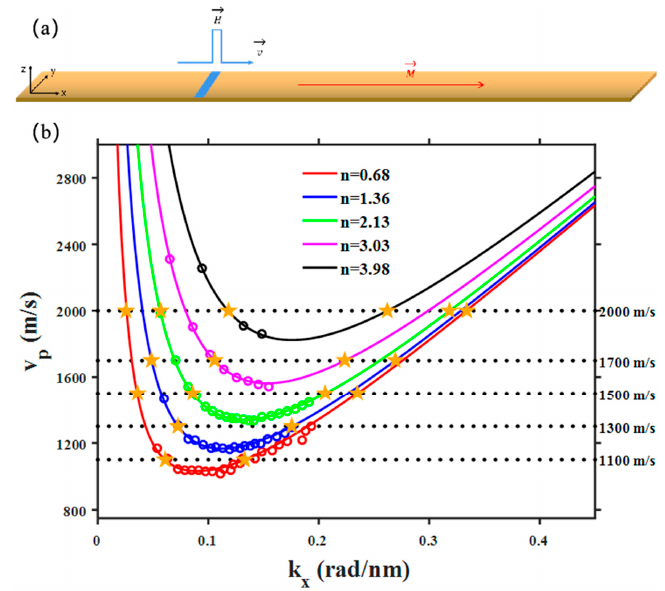
Figure 3. ( a ) A localized field pulse (blue) moving along the strip to generate Cherenkov-like excitation of SWs. ( b ) SW phase velocity versus wave vector extracted from the dispersion relation. Dots are numerical results and solid lines are fittings using Equation (2). Dashed lines help to identify multiple degeneracy of phase velocity of SW modes with different order numbers n . The yellow stars indicate modes that are degenerate in phase velocity that in principle can be co-excited by a particular moving field pulse.